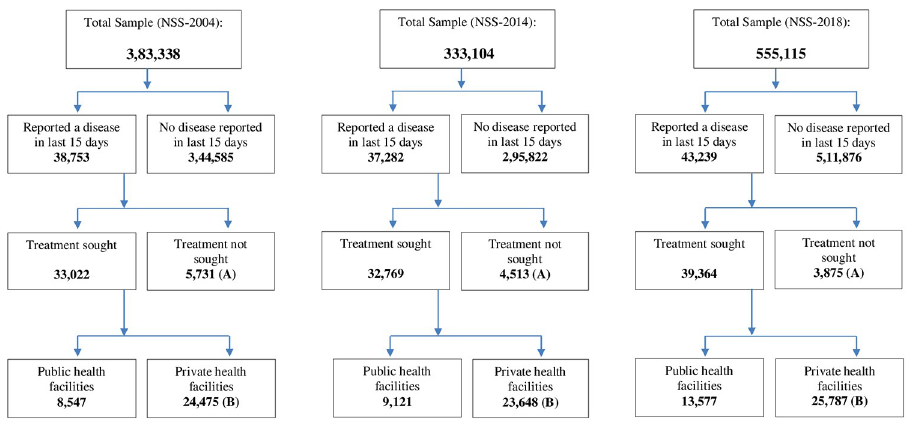
Fig 1. Analytical total sample at the Individual level in NSS-2004, 2014 and 2018,